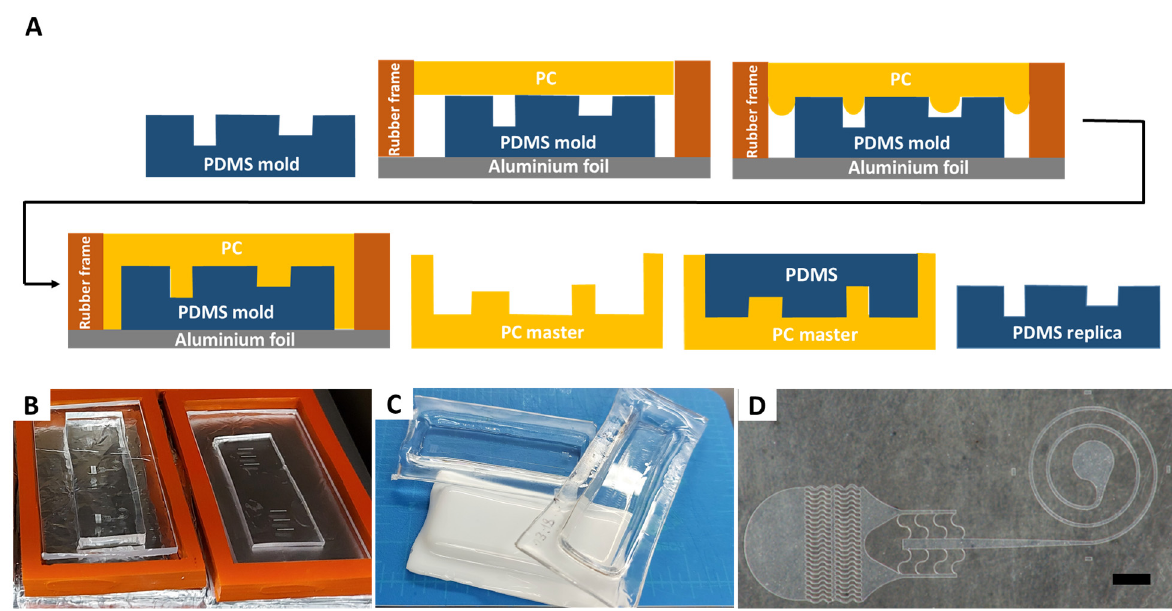
Figure 1. Polycarbonate master fabrication process. ( A ) Schematic diagram of the molding process. A PDMS soft lithography replica of the original master is used as a mold. Dried PDMS molds are placed in a vacuum oven over an aluminum foil with a heat resistant rubber frame around and a dried PC slab on top. Following baking process at 220 °C for 2–4 h, PC softens and re-flows around the microscale features. Once cooled to room temperature, PDMS mold is removed, and a rigid and durable PC master is obtained. The PC master is then used in multiple replication steps in place of the original master to cast PDMS replicas. ( B ) Photograph of the PC sheet on top of PDMS mold, inside a high temperature resistant rubber containment frame. ( C ) Examples of fabricated PC masters. ( D ) Bright field image of a representative PC master, illustrating an input port with filter and a spiral channel of a microfluidic device; scale bar is 1 mm.